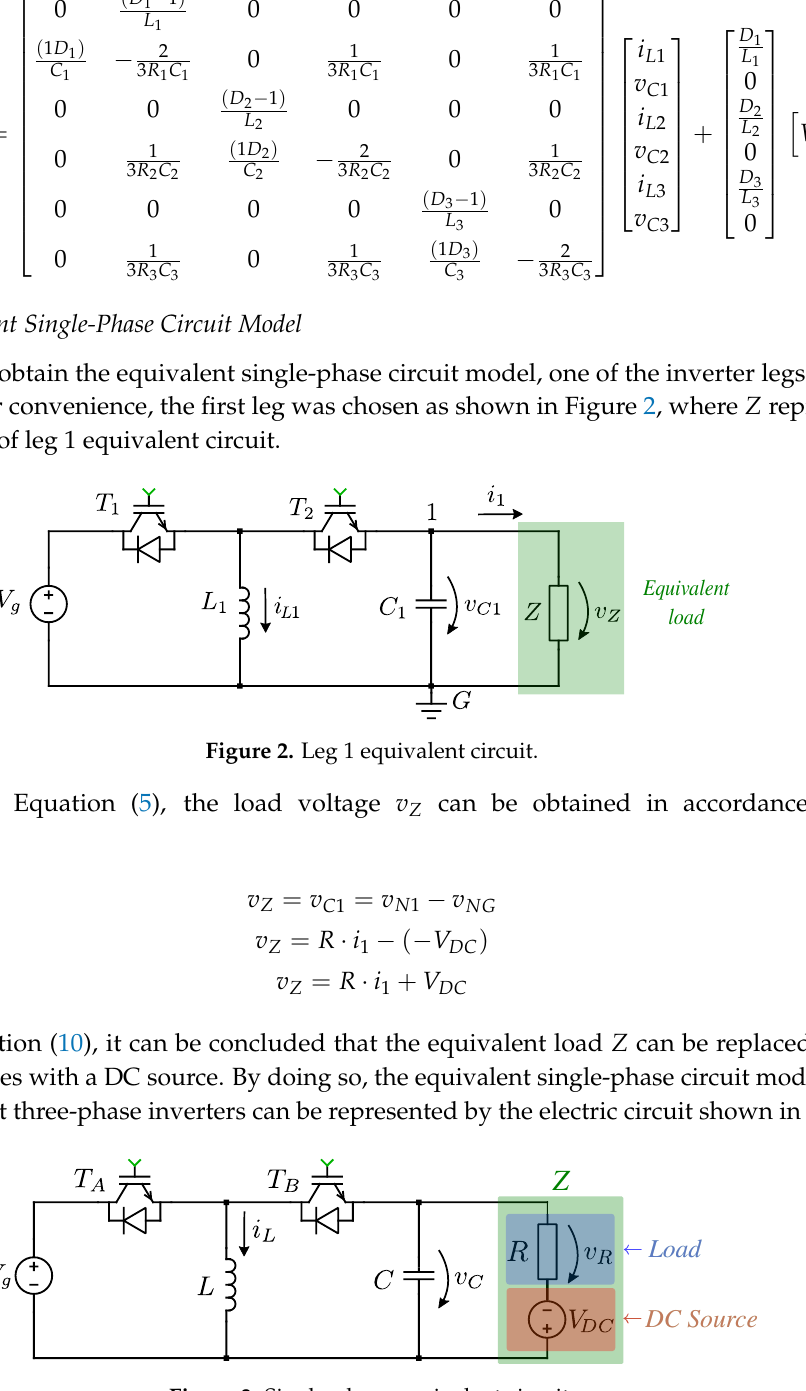
Figure 3. Single-phase equivalent